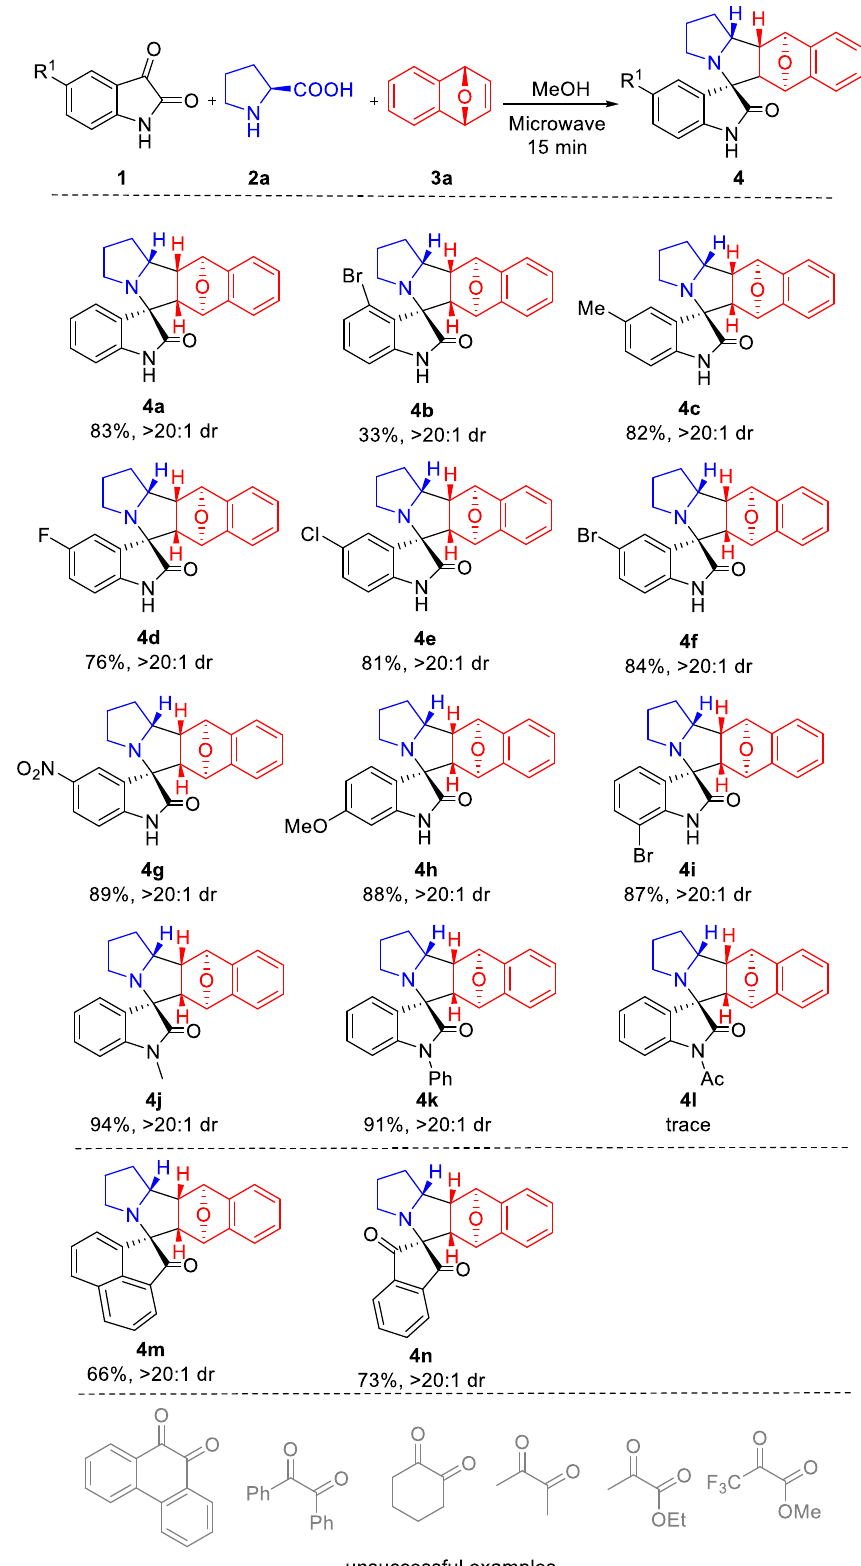
Scheme 2. Reaction scope with respect to isatins and α-dicarbonyl compounds. Reagents and con-